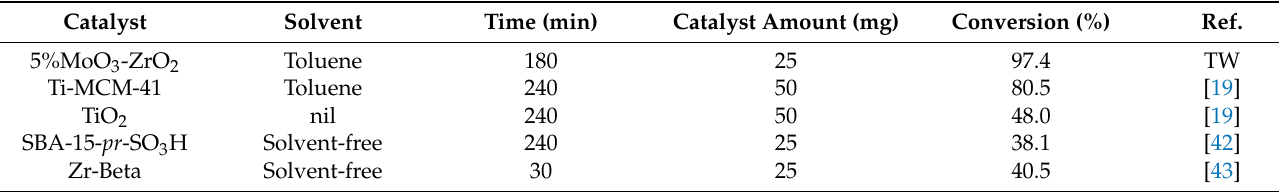
Table 3. A direct comparison of effectiveness of 5%MoO 3 -ZrO 2 on the aminolysis of styrene oxide with aniline and those catalyst reported in the literature.